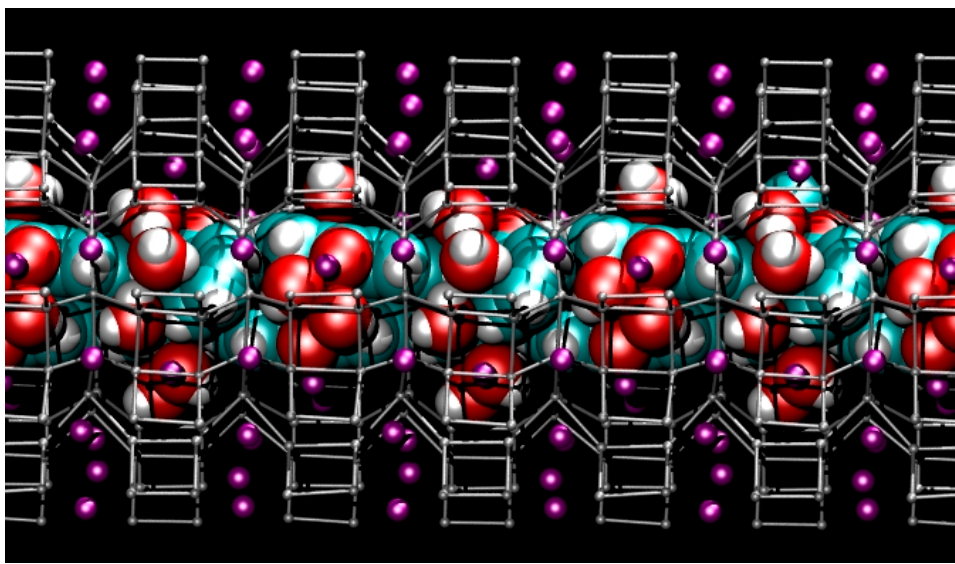
Figure 7. Snapshot from first-principles molecular dynamics (FPMD) simulation showing the structure of the hydrated ZL/1.5FL model with cell parameters corresponding to P = 1.95 GPa (side view of the 12 MR channel ‖ [001] axis). Colours are the same as reported in Figure 3.